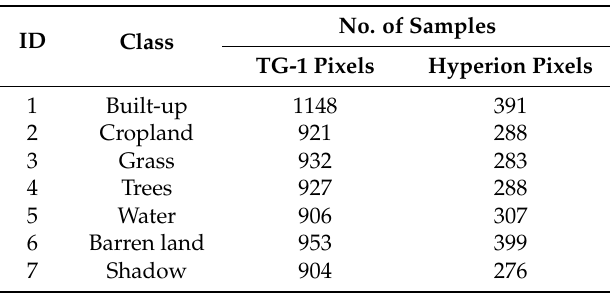
Figure 2. The ground truth area is labelled in red; the background image is the composite pan-sharpened GF-1 image (the spatial resolution of 2 m) of June 2013 in RGB combination of band 3, band 2, and band 1. Table 2. The seven spectral classes used for classification, and the number of pixels selected for each class using TG-1 and Hyperion sensors.